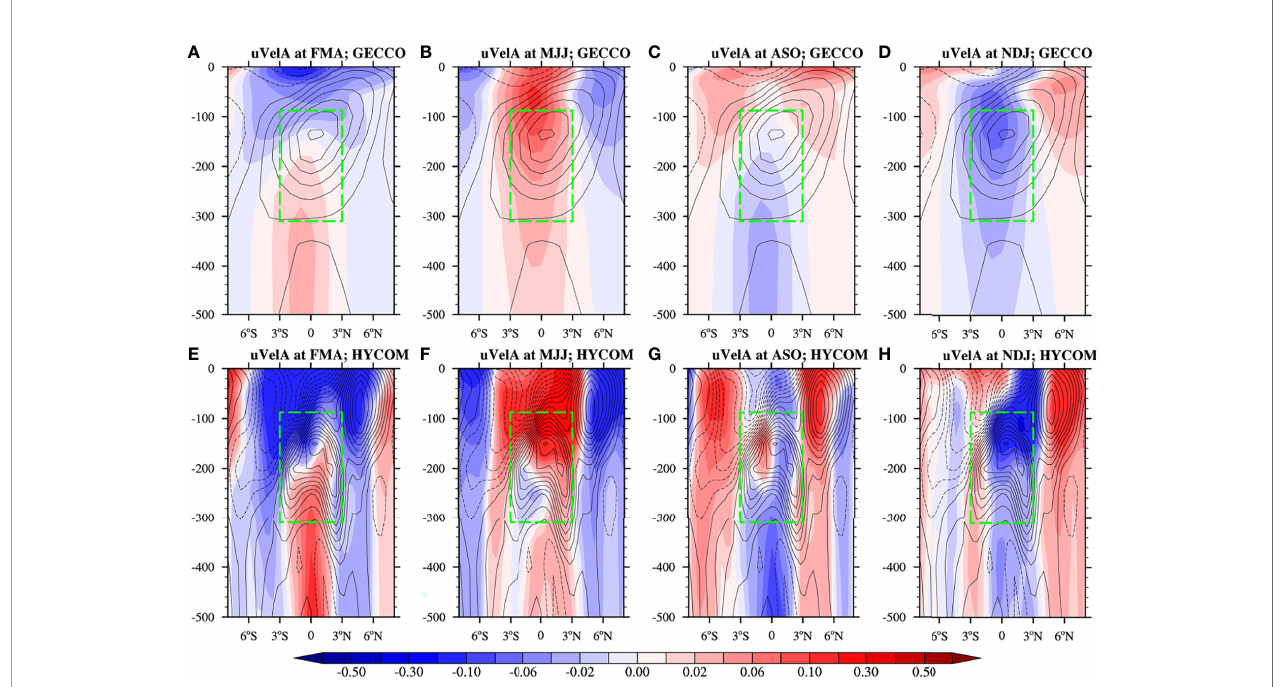
FIGURE 1 | Vertical structures of the climatological mean (contours; m s -1 ) and seasonal anomalies (color shading; m s -1 ) of the zonal velocity at 165°E derived from GECCO in boreal (A) spring, (B) summer, (C) autumn, (D) winter. (E – H) same as (A – D) , but from HYCOM. The solid lines represent the eastward velocity, and the dashed lines represent the westward velocity. The green dashed box represents the target section in the EUCT ’ s calculation. The interval of the contours is 0.03 m s -1 . Note the nonlinear shading levels in the color bar, and the climatological zonal velocity of HYCOM is averaged between 1994 and 2013.